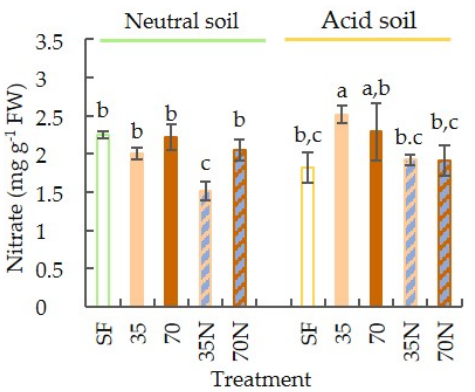
Figure 8. Effects of soil and MSWC supplemented or not with inorganic nitrogen on shoot nitrate concentrations. Note: FS—fertilized soil; 35—35 t MSW compost ha − 1 ; 70—70 t MSW compost ha − 1 ; 35 + N—35 t MSWC ha − 1 + 92 kg N ha − 1 ; 70 + N—70 t MSWC ha − 1 + 92 kg N ha − 1 . Means with